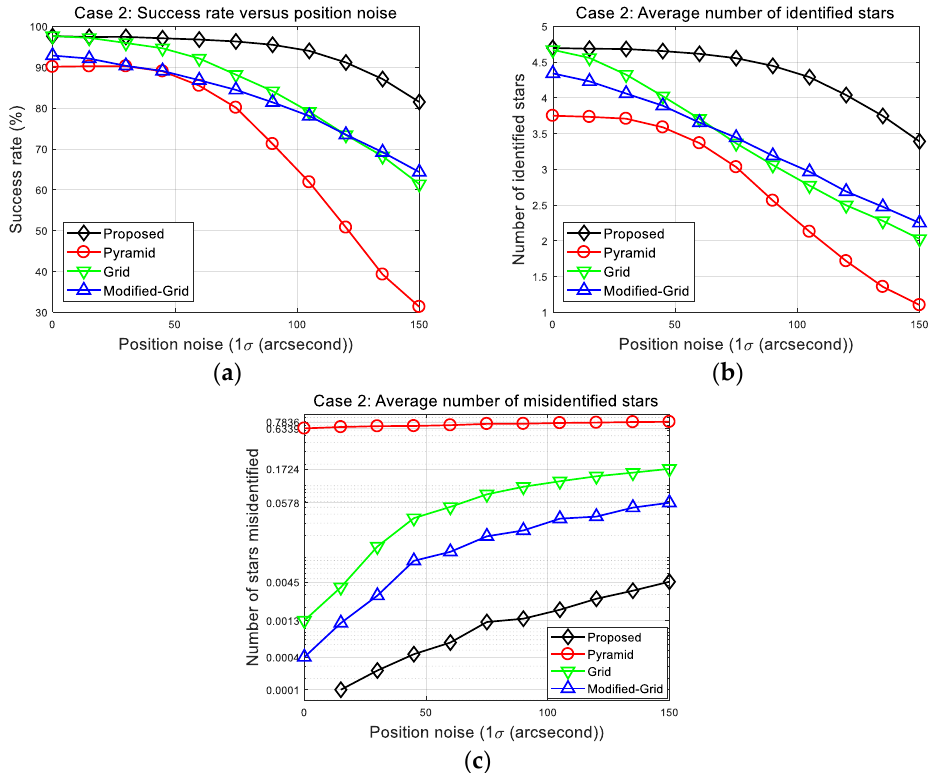
Figure 11. Case 2: ( a ) Success rates; ( b ) number of identified stars; ( c ) number of misidentified stars.